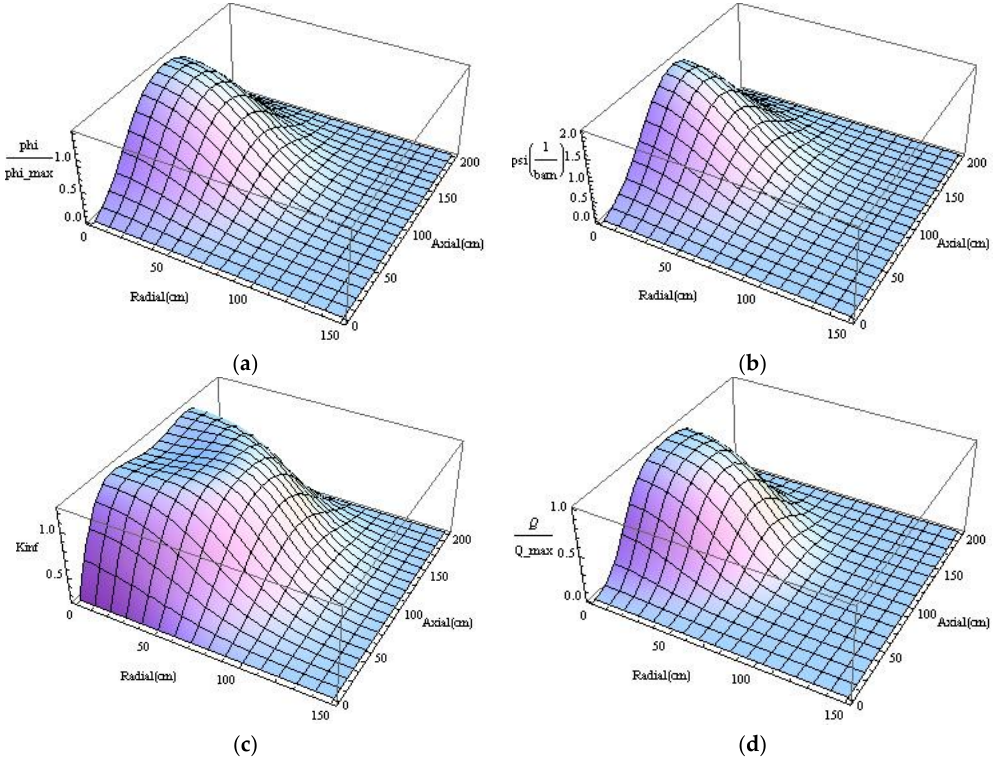
Figure 9. Distributions of neutron flux φ , fluence ψ , infinity multiplication factor k inf and the normalized power density in Case 3 in Table 3. ( a ) Neutron flux; ( b ) neutron fluence; ( c ) infinity multiplication factor; ( d ) power